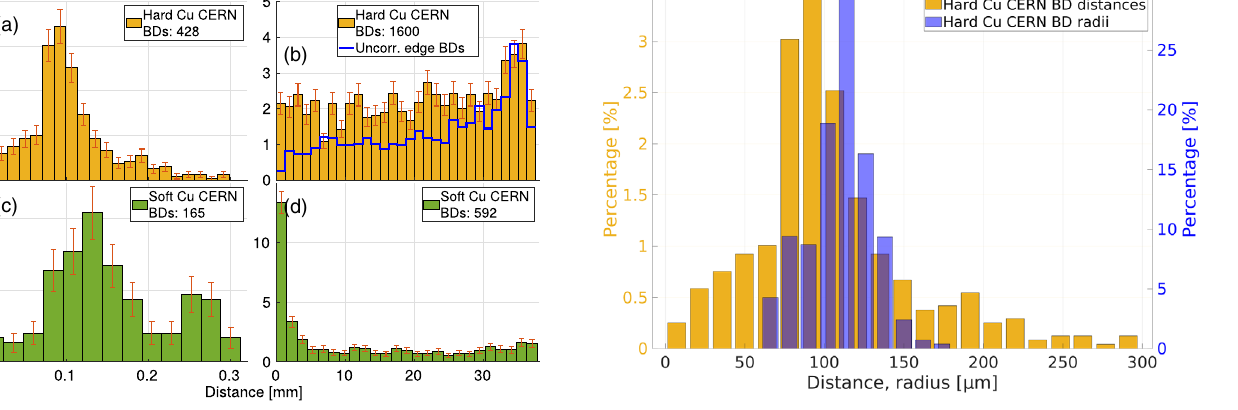
FIG. 8. Distribution of distances between breakdowns for hard and soft Cu, grouped by pulses between breakdowns with error bars showing the standard deviation. (a) and (c) show the distributions for ramping pulses where the only features in the distributions are visible within the first 300 μ m. (b) and (d) show the distributions for all the BDs at all distances for BDs after the ramping period. In addition, (b) shows the distribution distances between simulated uncorrelated edge BDs. The integral of each distribution equals to the fraction of breakdowns that fall within each pulse and distance range, so that both ranges combined equal 100%.